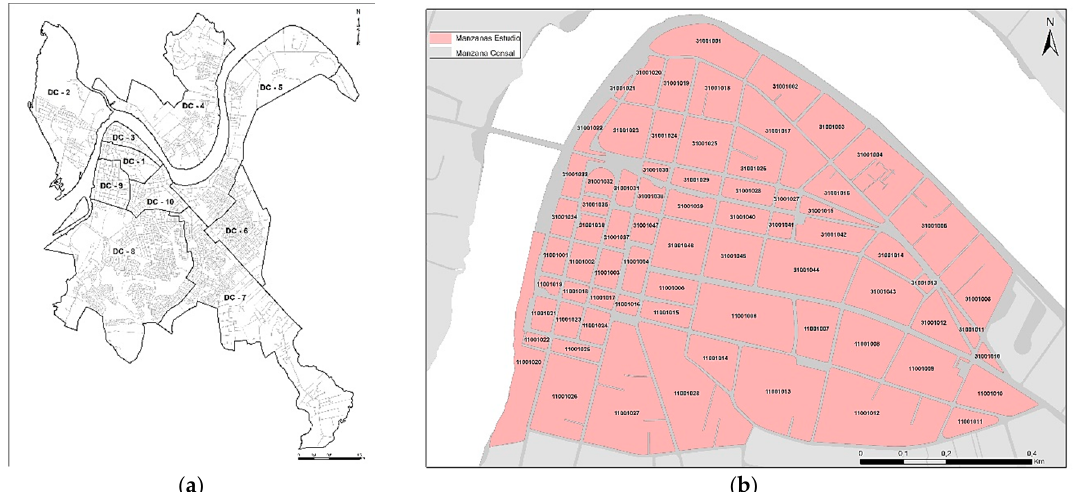
Figure 1. ( a ) Administrative division according to the National Institute of Statistics of Chile (INE) [4]; ( b ) Urban blocks contained within the study area [4].